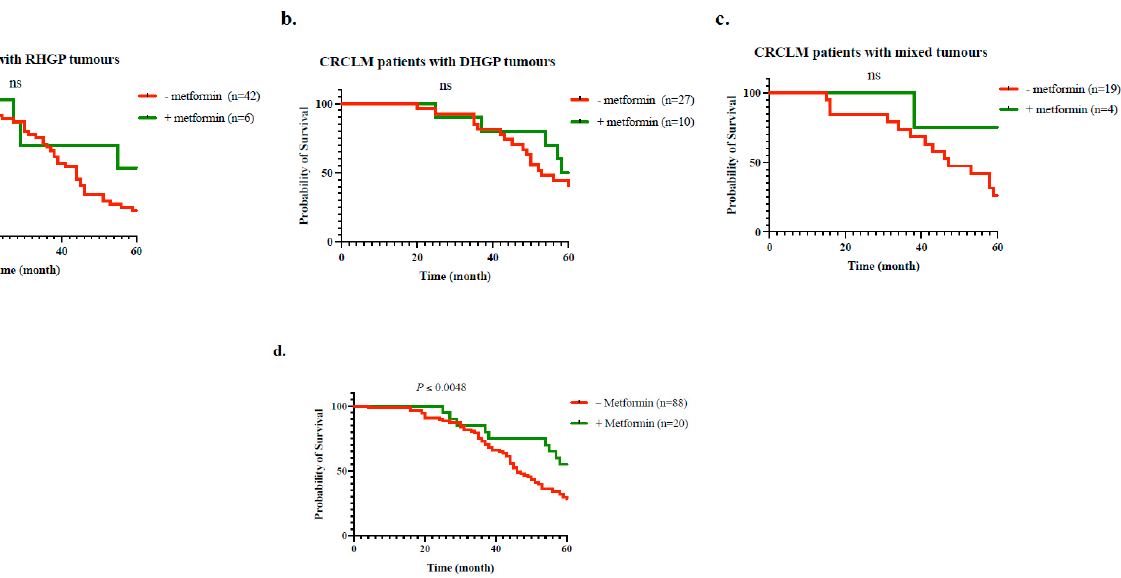
Figure 2. Metformin improves the prognosis of CRCLM patients. The survival analysis shows five-year overall survival rate of CRCLM patients with ( a ) RHGP, ( b ) DHGP, or ( c ) mixed tumours in the presence or absence of metformin usage. ( d ) The difference in five-year overall survival between cohorts treated with and without metformin among all CRCLM patients. Kaplan–Meier analysis with log-rank tests was used to analyze the survival curves and statistical